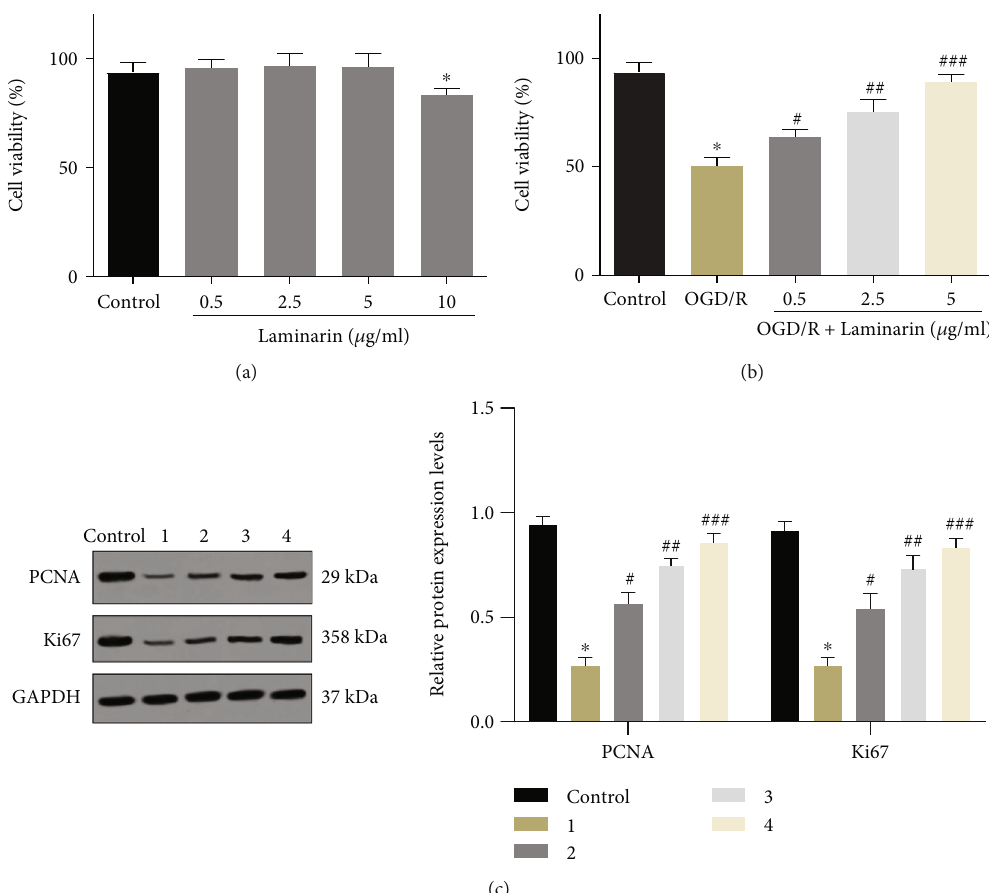
Figure 1: E ff ect of di ff erent concentrations of laminarin on the viability of PC12 cells induced by OGD/R. (a) CCK-8 was used to detect the e ff ects of di ff erent concentrations of laminarin (0.5, 2.5, 5, and 10 μ g/ml) on the viability of PC12 cells. (b) CCK-8 was conducted to detect the e ff ects of di ff erent concentrations of laminarin (0.5, 2.5, and 5 μ g/ml) on the viability of PC12 cells induced by OGD/R. (c) Western blot assay was performed to detect the e ff ects of di ff erent concentrations of laminarin (0.5, 2.5, and 5 μ g/ml) on the protein expression levels of PCNA and Ki67 in PC12 cells induced by OGD/R. Note: 1: OGD/R group, 2: OGD+0.5 μ g/ml laminarin group, 3: OGD+2.5 μ g/ml laminarin group, and 4: OGD+5 μ g/ml laminarin group. Compared with the control group, ∗ P < 0 : 05 ; compared with the OGD/R group, # P < 0 : 05 , ## P < 0 : 01 , and ### P < 0 : 001